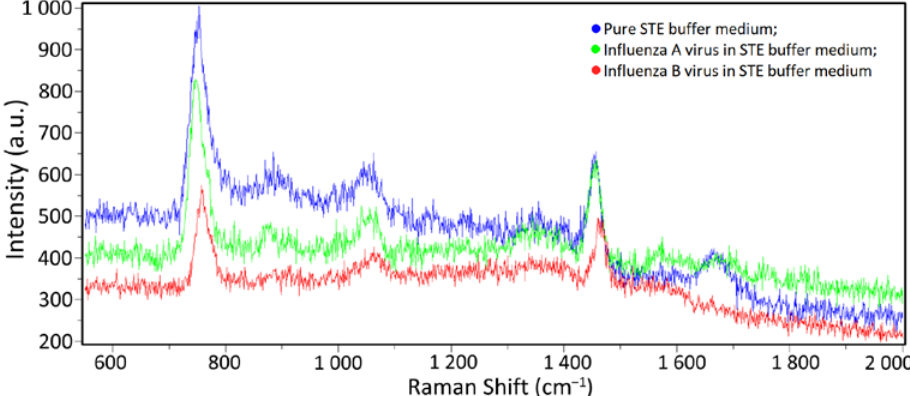
Figure 5. Relative comparison of the spectra: blue line—the pure STE buffer medium; green line— influenza A virus in the STE buffer medium; red line—influenza B virus in the STE buffer medium.